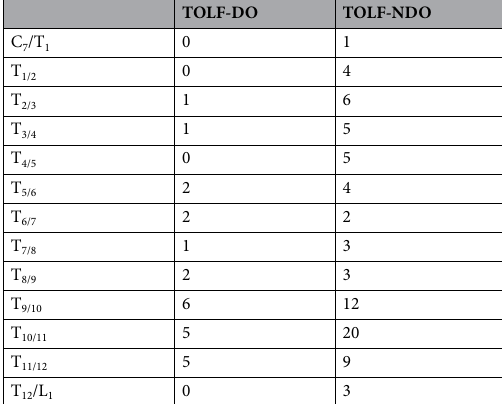
Table 1. Segments locations of patients with TOLF.